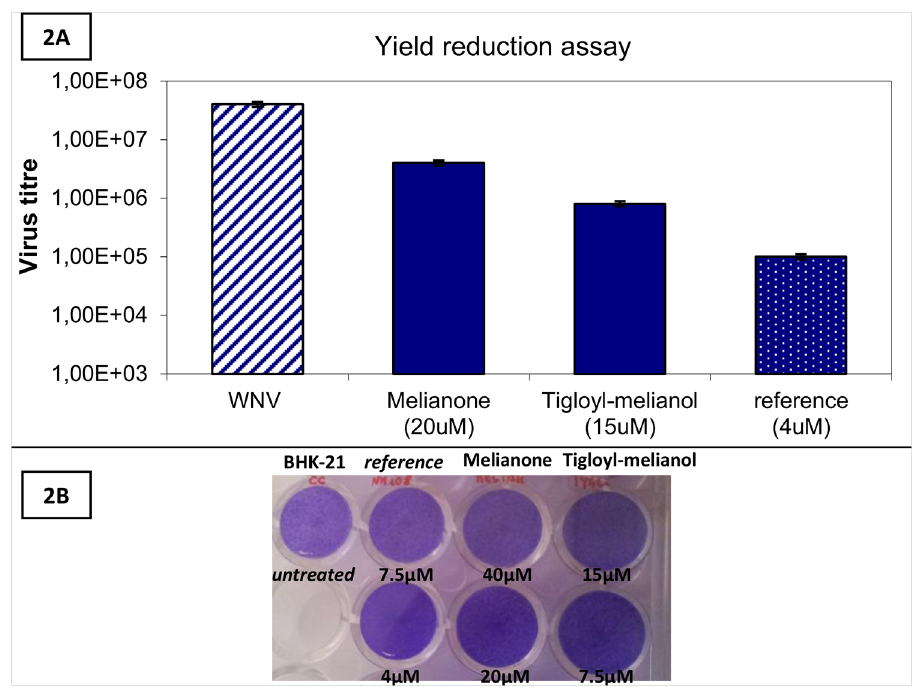
Fig 2. Yield reduction assay. 2A. Reduction of WNV titre in presence of not cytotoxic concentrations of melianone (20 μ M) and 3-tigloyl-melianol (15 μ M). 2 ’ -C-methylguanosine was used as reference compound (at 4 μ M). 2B. The BHK-21 monolayers treated with the above compounds did not show significant cytopathic effects at the tested concentrations.